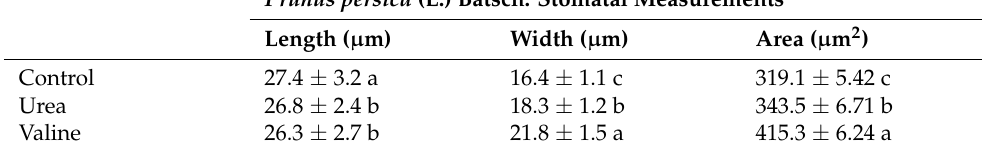
Table 1. Stoma length, width, and area. Prunus persica (L.) Batsch. Stomatal Measurements